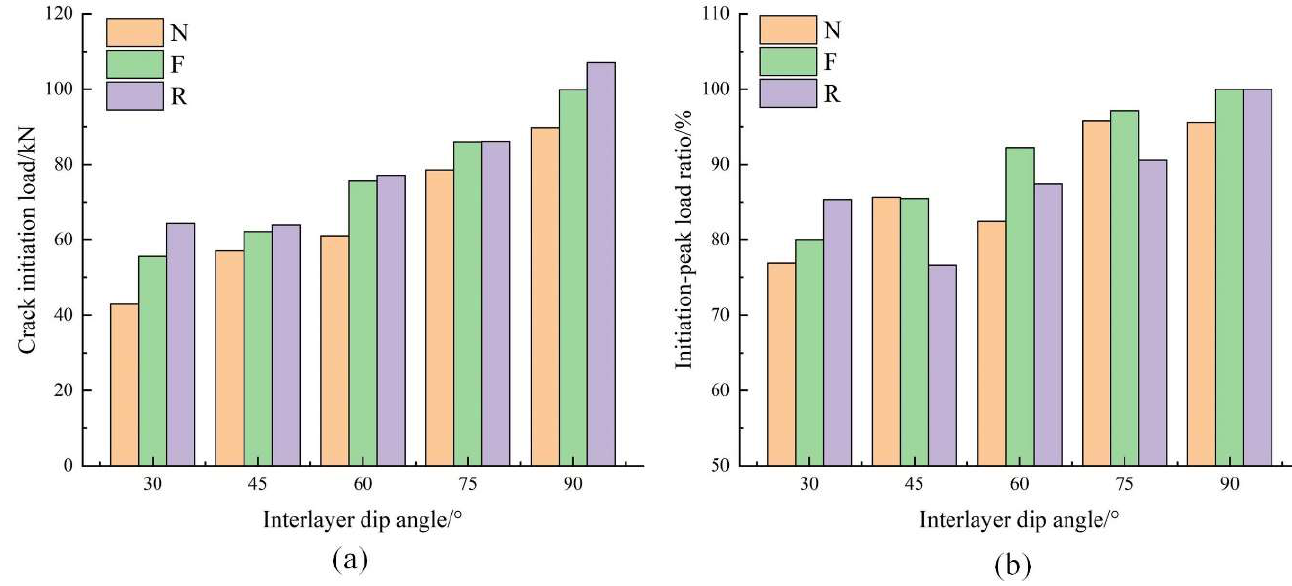
Figure 13. Crack initiation load and initiation-to-peak load ratio of all samples. ( a ): crack initiation load ( b ): initiation-to-peak load ratio.